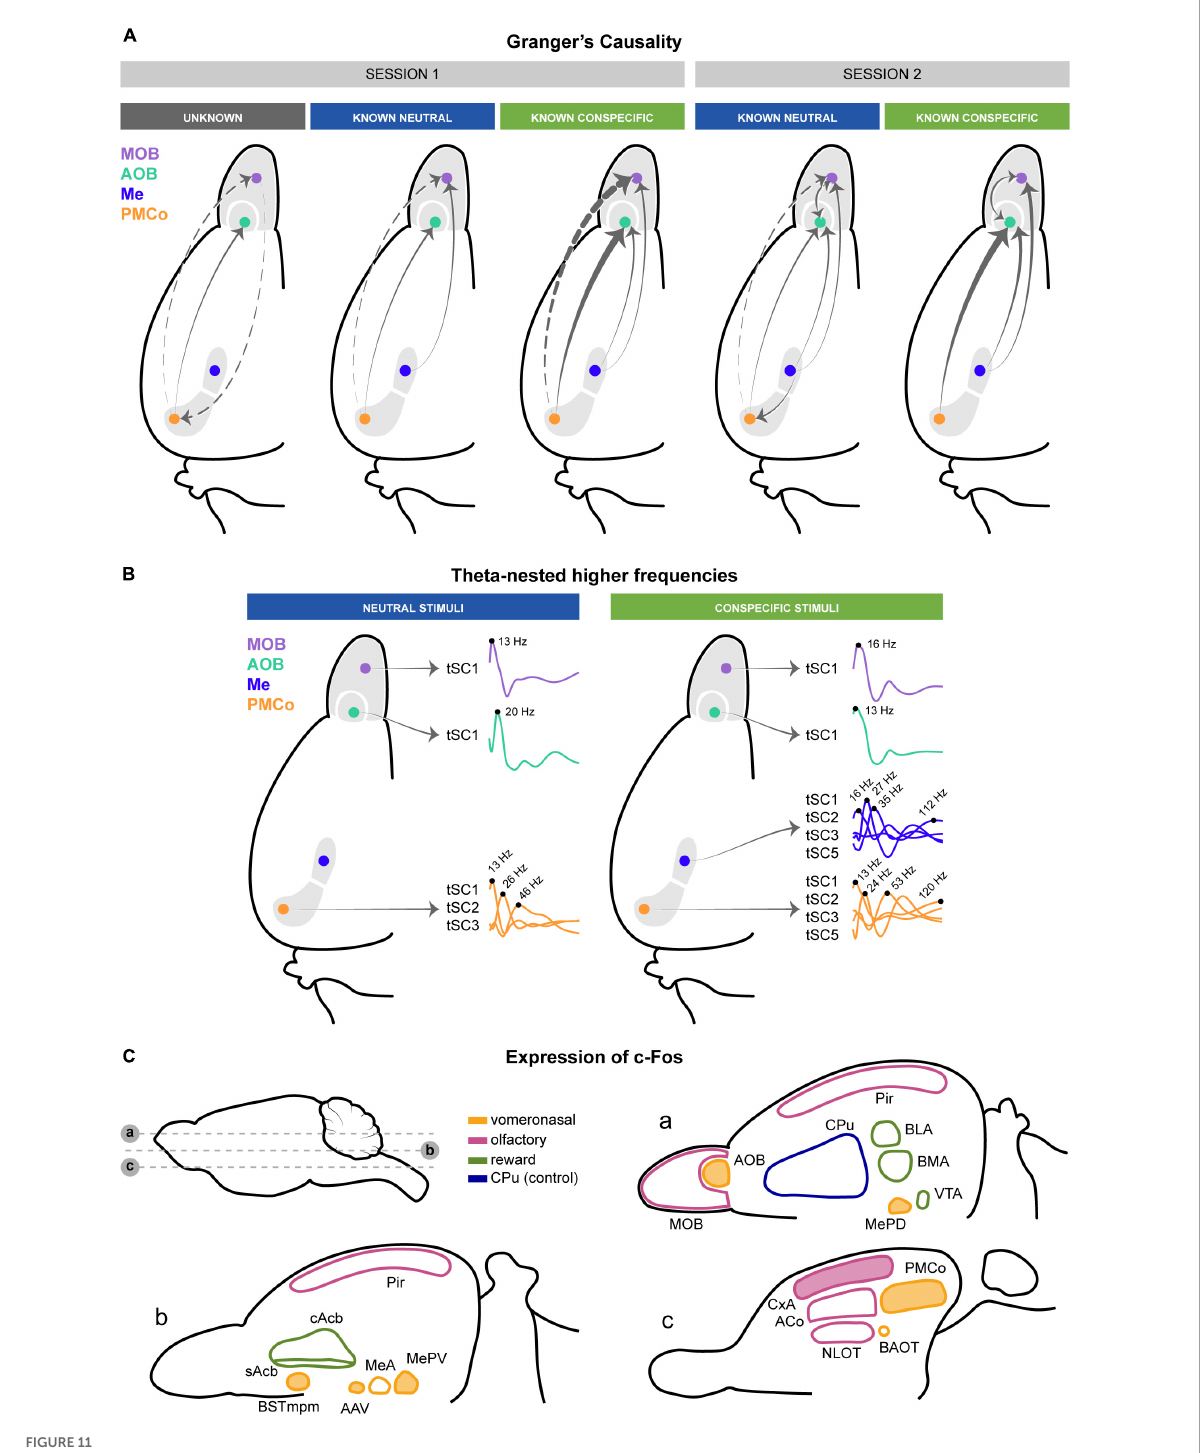
FIGURE11 Schematic summary of the causality, theta-nested higher frequencies, and c-Fos expression involved in processing chemosensory cues. (A) Top-down and bottom-up transfer of information between the amygdala and the main and accessory olfactory bulbs summarizing Figure 3A . The thickness of the arrows reflects the intensity of the GC. Dashed arrows indicate indirect anatomical connections. (B) Theta-nested higher frequencies define the bulbo–amygdalar neuronal processing. Only tSCs with significant increases are shown. (C) Activation of the vomeronasal systems and CxA by male-derived chemical signals revealed by c-Fos expression. Significant (filled) and non-significant (non-filled) structures in the vomeronasal (yellow), olfactory (magenta), and reward (green) circuits of female mice exposed to citralva or male urine. The caudatus-putament, analyzed as control, is depicted in